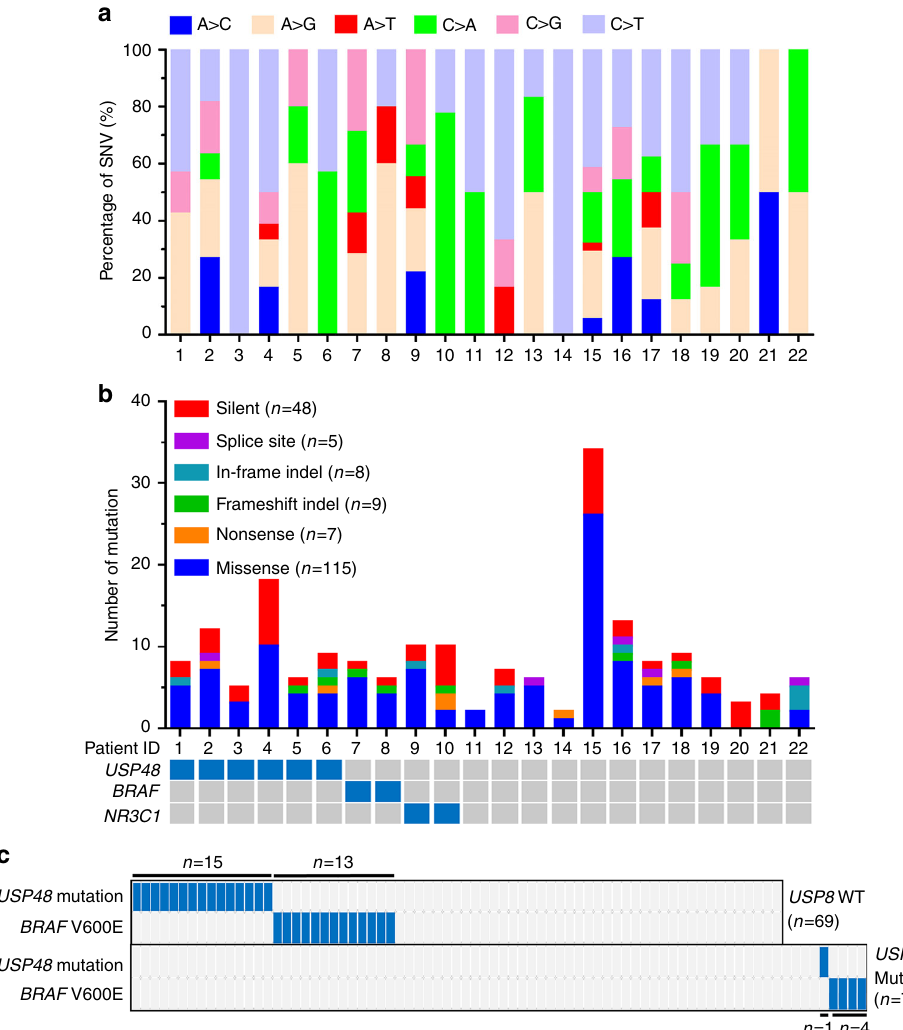
Fig. 1 Whole-exome sequencing and targeted sequencing in corticotroph adenomas. a Percentage of non-silent somatic SNVs identi fi ed by whole-exome sequencing in 22 subjects with corticotroph adenomas carrying wild-type USP8 . b The number and type of somatic mutations identi fi ed by whole-exome sequencing (top). The mutational status of the indicated genes in each patient is shown at the bottom. c Mutation frequency of the indicated genes in corticotroph adenomas with wild-type or mutated USP8 by targeted sequencing. Each column represents a single case. n : number of subjects. Patients with the indicated mutations are marked in blue ( b, c